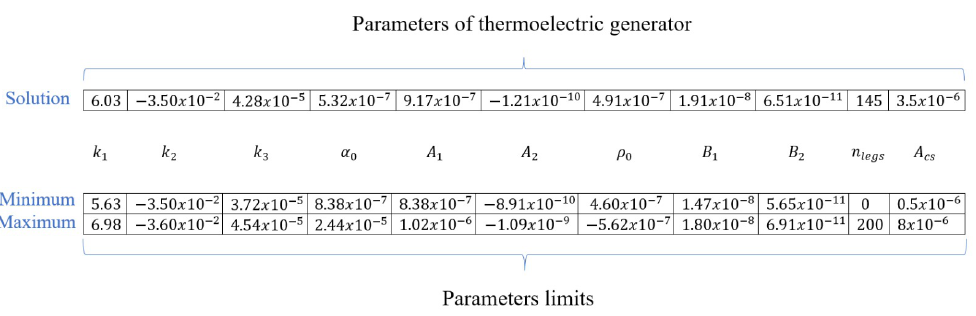
Figure 2. Codification proposed for solving the problem of Material Property Characterization and Parameter Estimation of Thermoelectric